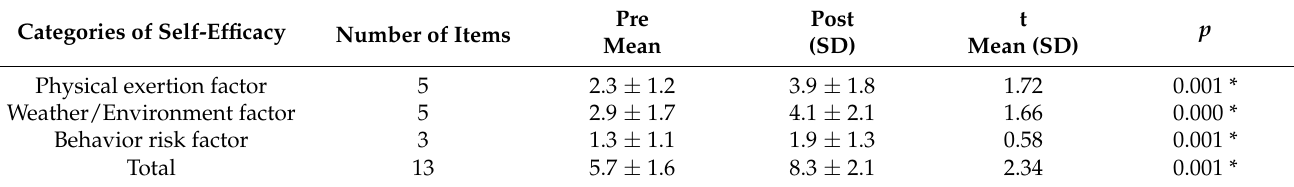
Table 4. Comparison between categories and scores of self-efficacy pre- and post-empowerment (N = 60). Categories of Self-Efficacy